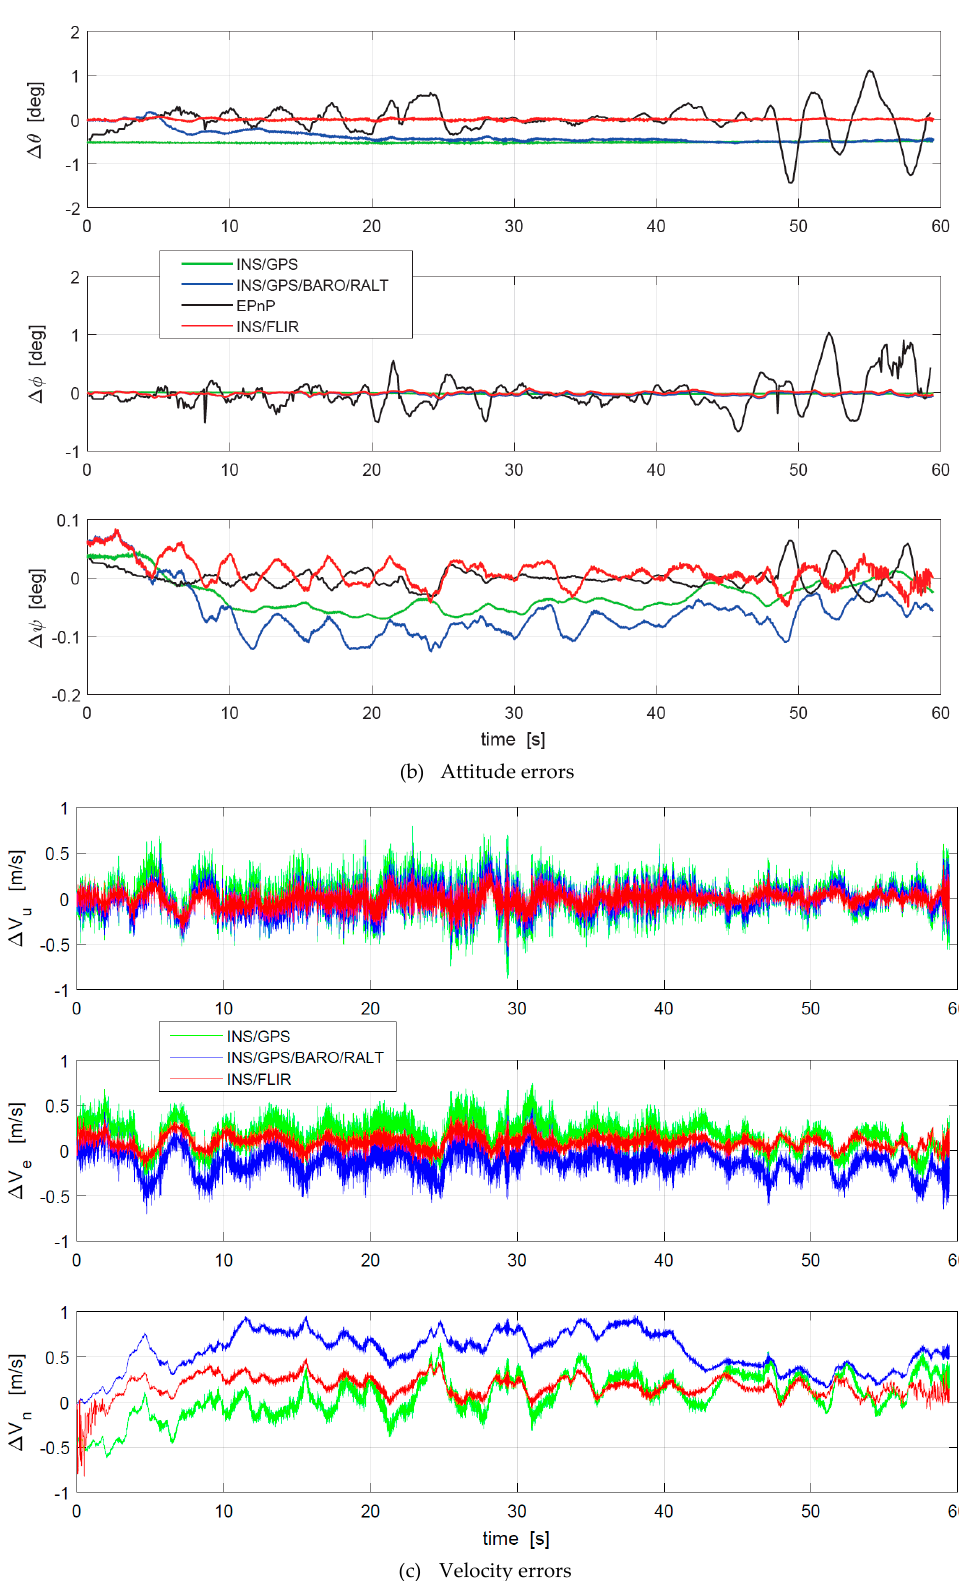
Figure 12. Errors of motion estimation: ( a ) position errors, ( b ) attitude errors, and ( c ) velocity errors.